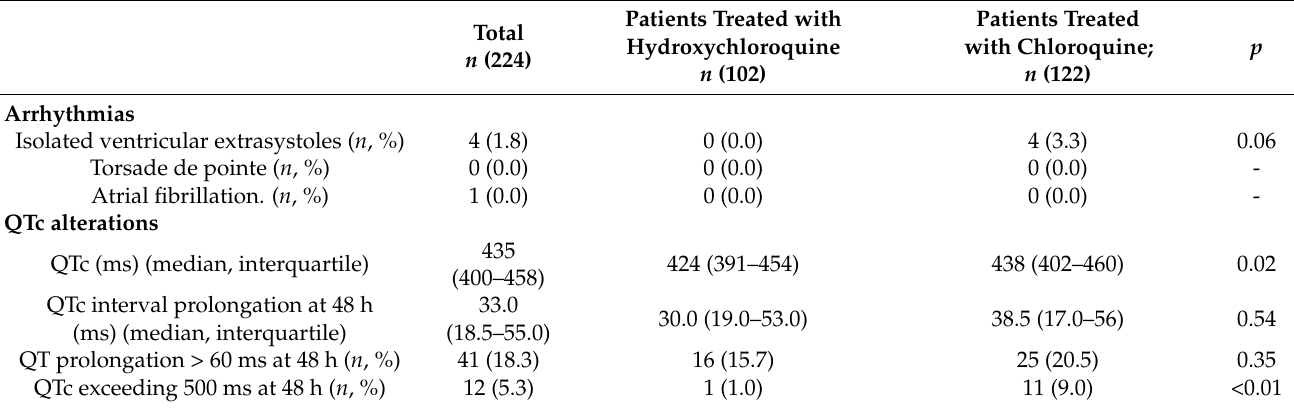
Table 2. QTc alterations and prevalence of rhythm disorders in COVID-19 patients at 48